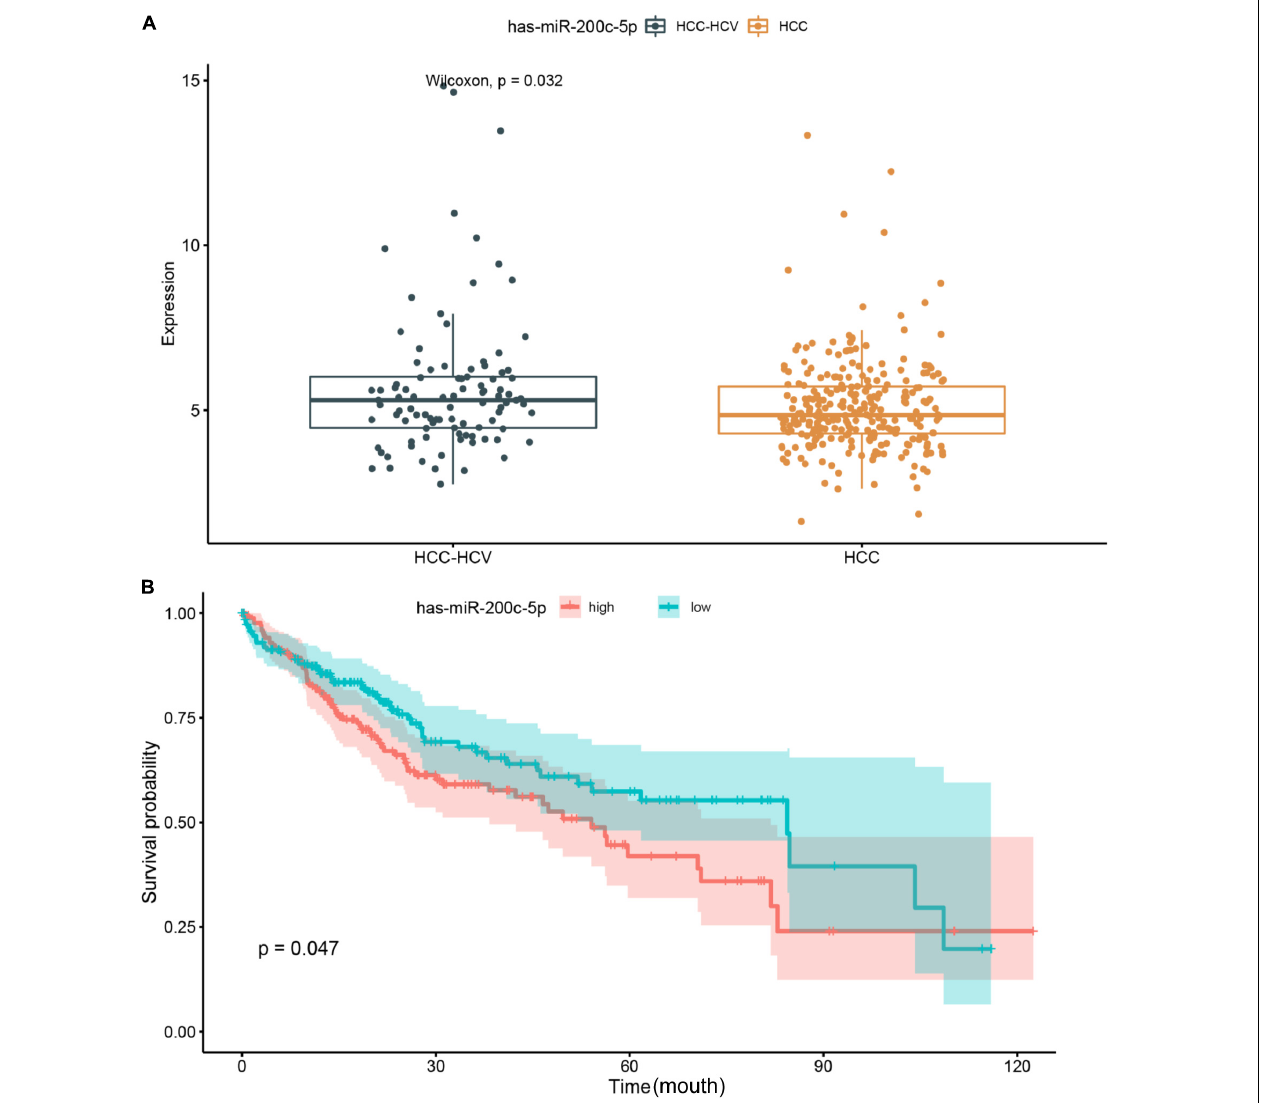
FIGURE 6 | Relationship between miR-200c expression level and patient prognosis. (A) Significant difference was found in the miR-200c expression between HCC-HCV and HCC patients. (B) HCC patients with high miR-200c expression have a relatively poor prognosis. HCC, hepatocellular carcinoma; HCV, hepatitis C